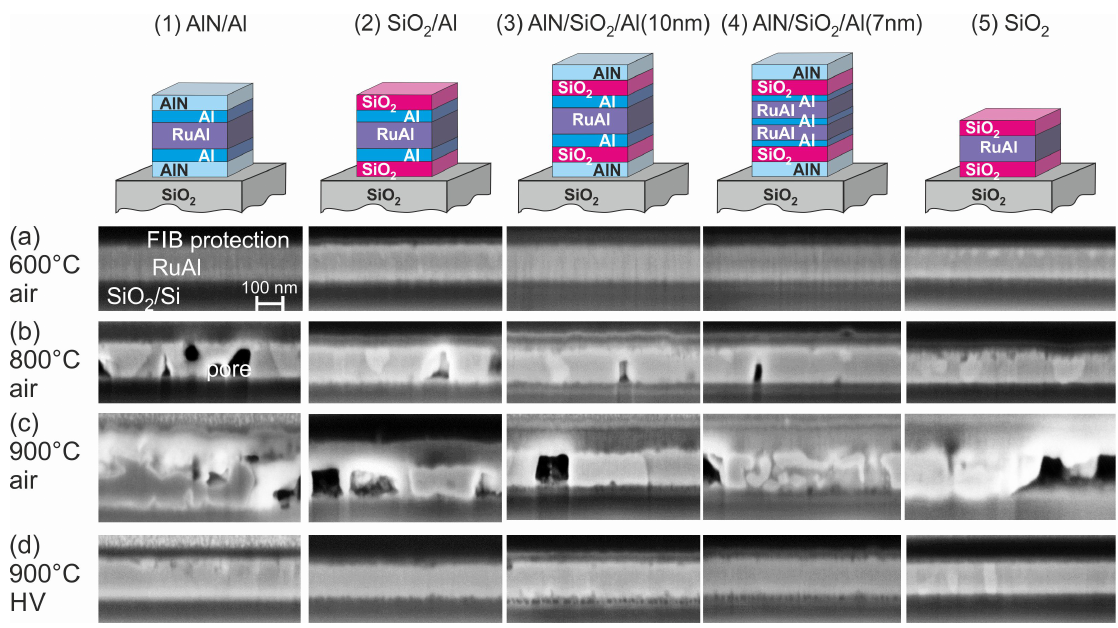
Figure 2. SEM images (inLens, 3 kV) of cross-sections of the RuAl thin films with various protection layers on SiO 2 /Si after annealing in air for 10 h at ( a ) 600 ◦ C, ( b ) 800 ◦ C, ( c ) 900 ◦ C, and ( d ) in high vacuum at 900 ◦ C.